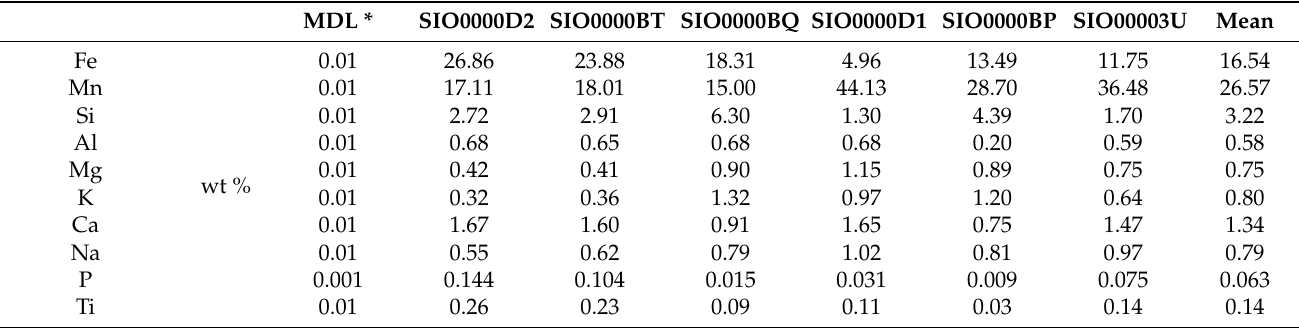
Figure 4. Bulk XRD data of dried (40 ◦ C/24 h) and roasted (105 ◦ C/24 h) crust samples from C- Q—quartz. Peak positions (d-spacing) of identified minerals shown with different colors. Presence of a low number of collapsed manganates identified based on decrease of ~9.7 Å peak during roasting and simultaneous increase of ~7 Å peak. Traces of clay minerals are mostly characteristic of montmorillonite group. Traces of relatively pure Mn-oxyhydroxides (manganite) were observed in two samples (see Table 2). Table 3. Chemical composition of bulk Fe-Mn crust samples as determined by XRF and ICP-MS methods. The ICP-MS expanded uncertainty of the results: p = 95%, coverage factor k = 2. The XRF precision accuracy was determined after 24 experimental measurements (each measurement taking 8